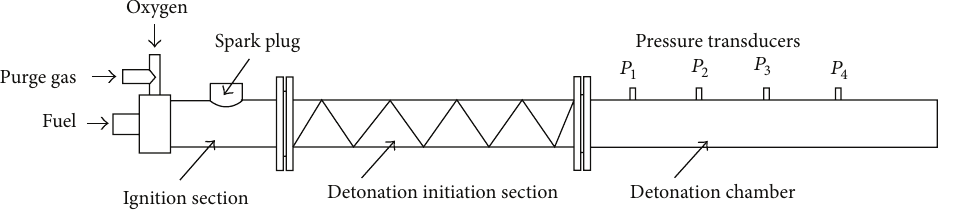
Figure 1: Schematic diagram of detonation tube with spiral [19].